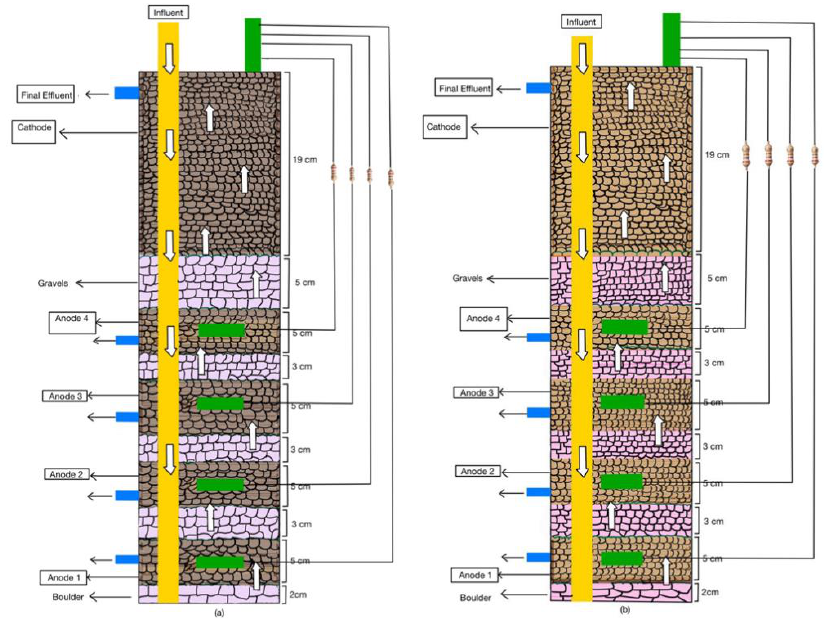
Figure 1. A schematic representation of configurations of ( a ) CW-MFC(GG) and ( b ) CW-MFC (GAC) setups used for the study.